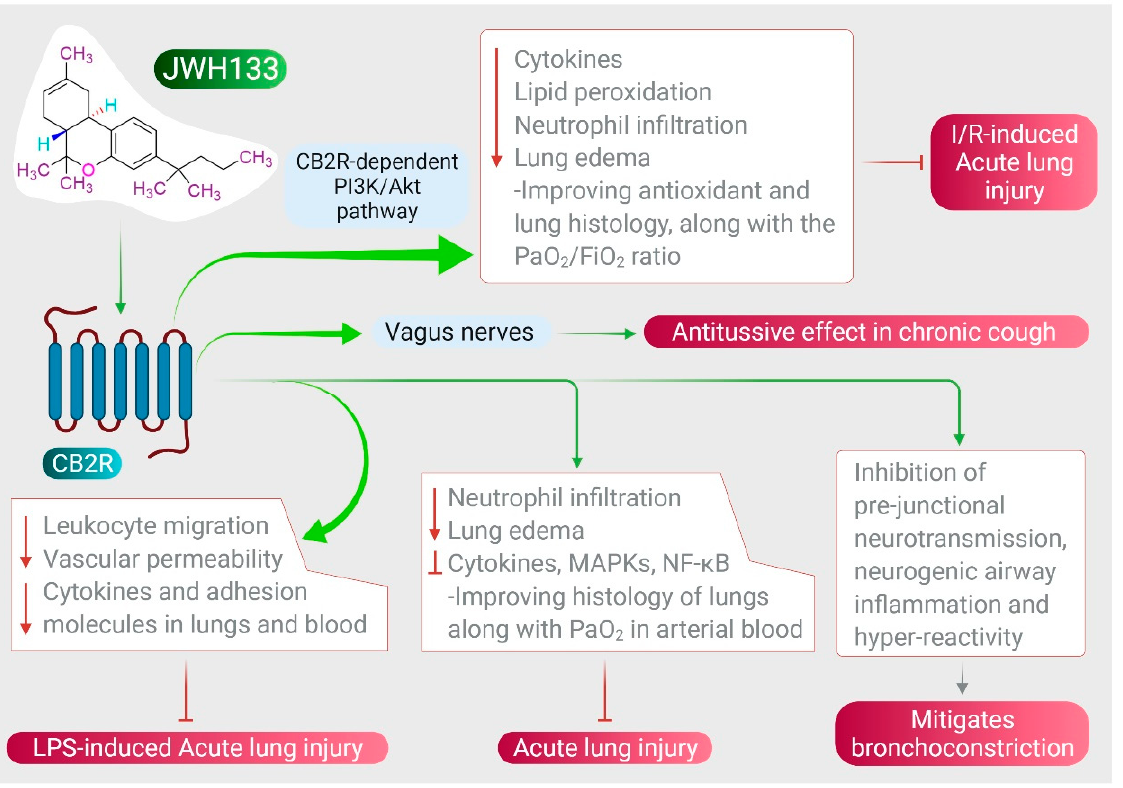
Figure 3. Effect of JWH133 on acute lung injury and airway activity.